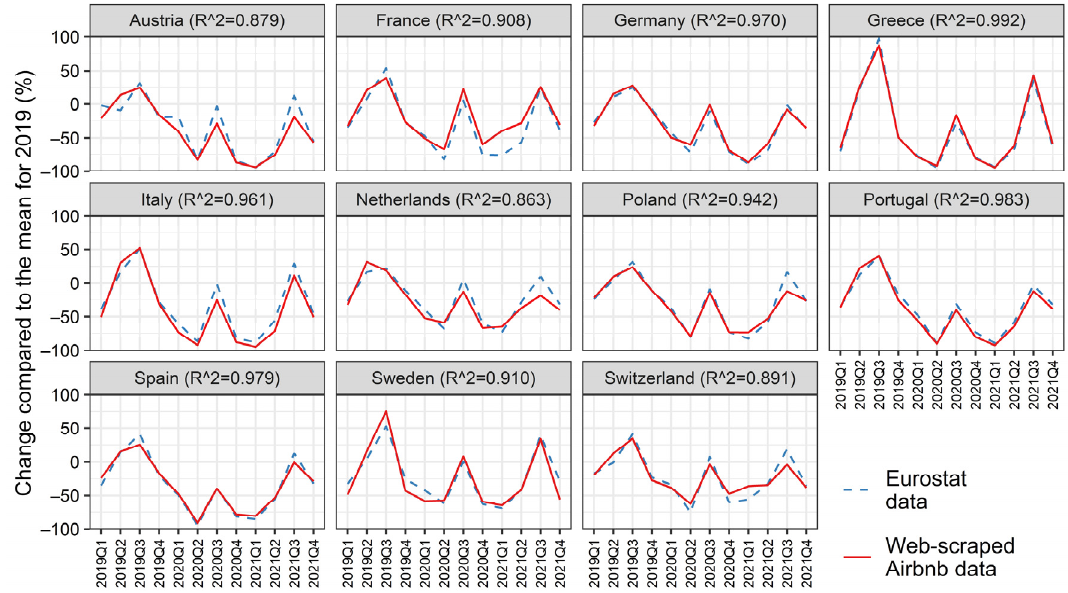
Figure 1. Dynamics of tourism stays 2019–2021 measured by Eurostat statistics and estimated based on web-scraped Airbnb data in nine European countries.